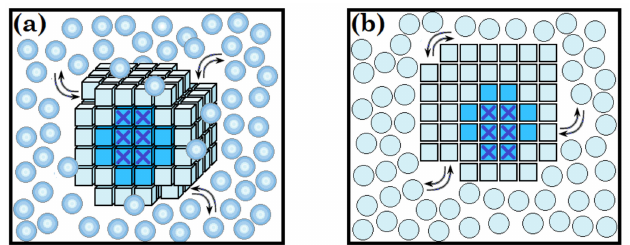
Figure 1. A schematic presentation of a compact structured piece of the emerging 3D phase in bulk liquid ( a ), and of the emerging 2D phase at a surface ( b ): The pieces of the “new” structured phases shown as cubes in panel ( a ) and squares in panel ( b ) arise from “free” particles of the liquid (balls in panel ( a ) and circles in panel ( b )). Dark blue cubes and squares represent the “seeds” in the structured pieces—that is, the smallest minimally stable (as compared to the liquid) parts of the structured phases; light blue cubes and squares are particles that stick to these “seeds” later. Dark blue crosses are the “nuclei” within the “seeds”, i.e., entities displaying the minimal stability during the structuring